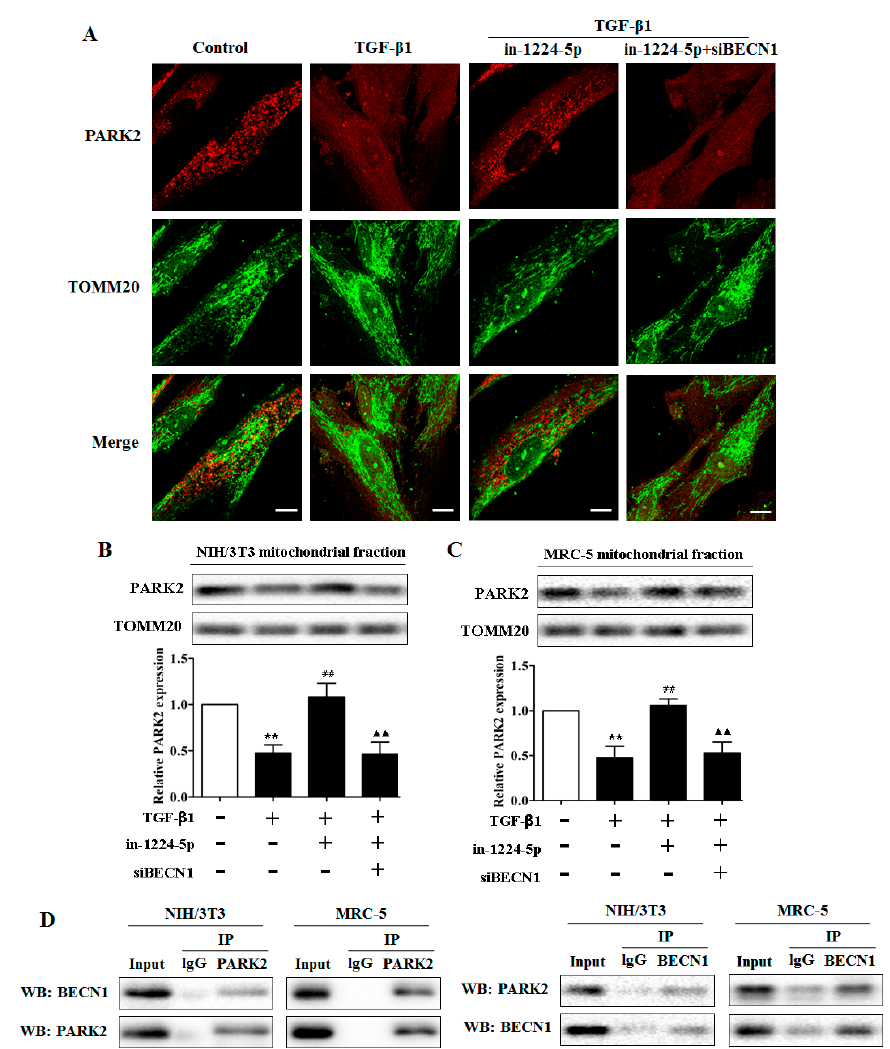
Figure 5. BECN1 facilitates PARK2 translocation to mitochondria. ( A ) Photographs of fluorescence staining by confocal microscopy evaluation in MRC-5 cells transfected with miR-1224-5p inhibitor (in-1224-5p) or co-transfected with in-1224-5p and BECN1 siRNA (siBECN1). TGF- β 1 treatment (2 ng/mL) was started 24 h post-transfection and staining was performed after 48 h treatment. PARK2 expression was detected using an anti-PARK2 antibody and anti-TOMM20 antibody was used for mitochondria. Scale bar: 10 µm; ( B , C ) Western blot and densitometric analysis in in-1224-5p transfected or in-1224-5p and siBECN1 co-transfected fibroblasts (NIH/3T3 and MRC-5). TGF- β 1 treatment (2 ng/mL) was started 24 h post-transfection and protein samples for mitochondrial fractions were collected after 48 h treatment, with ** p < 0.01 vs. the control group and ## p < 0.01 vs. the TGF- β 1 group and ▲▲ p < 0.01 vs. the TGF- β 1 plus in-1224-5p group; ( D ) Endogenous protein-protein interactions between PARK2 and BECN1 in fibroblasts (NIH/3T3 and MRC-5) were determined by immunoprecipitation (IP) with PARK2 or BECN1 antibodies followed by Western blot analysis. IgG was used as negative control for IP. All data are expressed as the mean ± SD of at least three independent experiments.